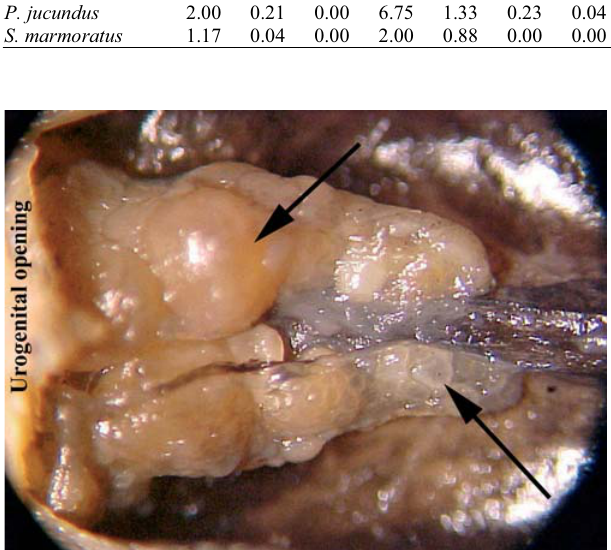
(Table 5; Fig. 12). Fig. 10. Female of Hisonotus sp. (32.8 mm SL) showing the